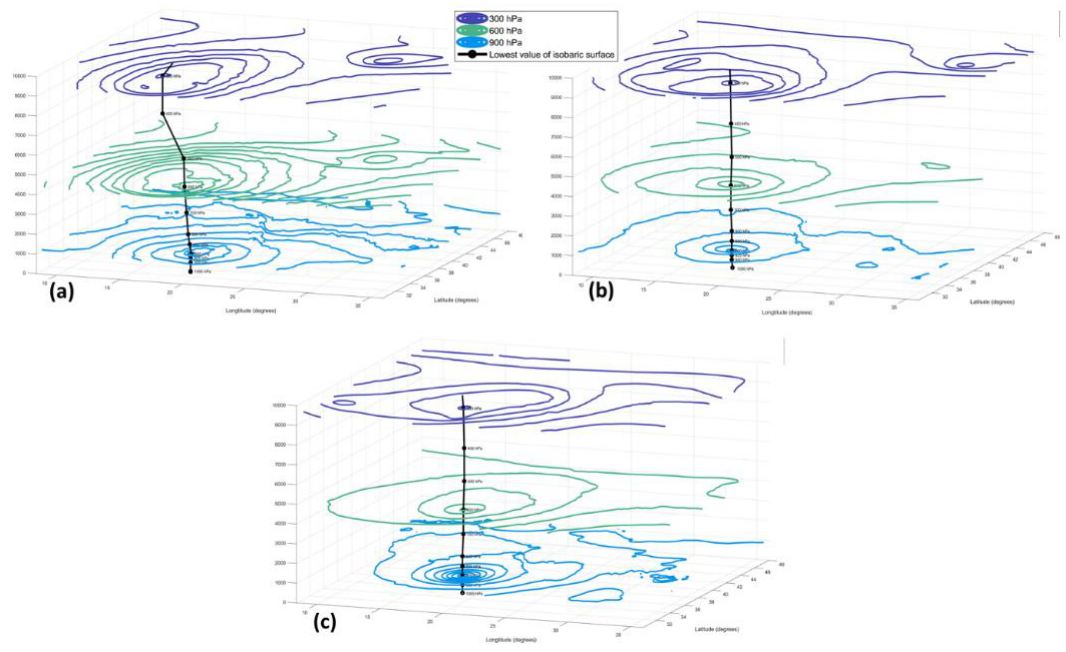
Figure 6. Three-dimensional representation of the geopotential height distribution around the cyclone centre at 900 hPa (light blue), 600 hPa (green) and 300 hPa (dark blue) at ( a ) 27/18 UTC, ( b ) 28/06 UTC, and ( c ) 28/18 UTC. Black dots represent the minimum value of geopotential height at each isobaric level and black line represents the vertical tilt with height (in meters).